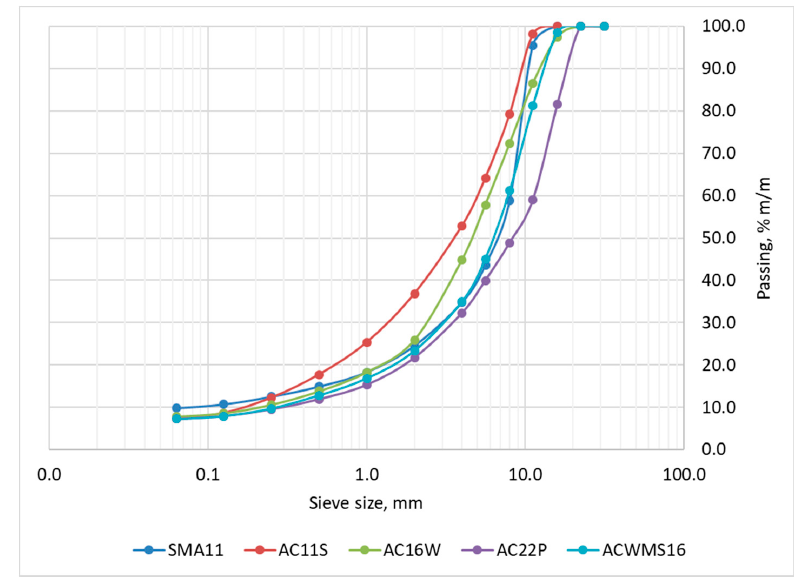
Figure 3. Grading curves. Table 2. Results of the mixture fatigue test.